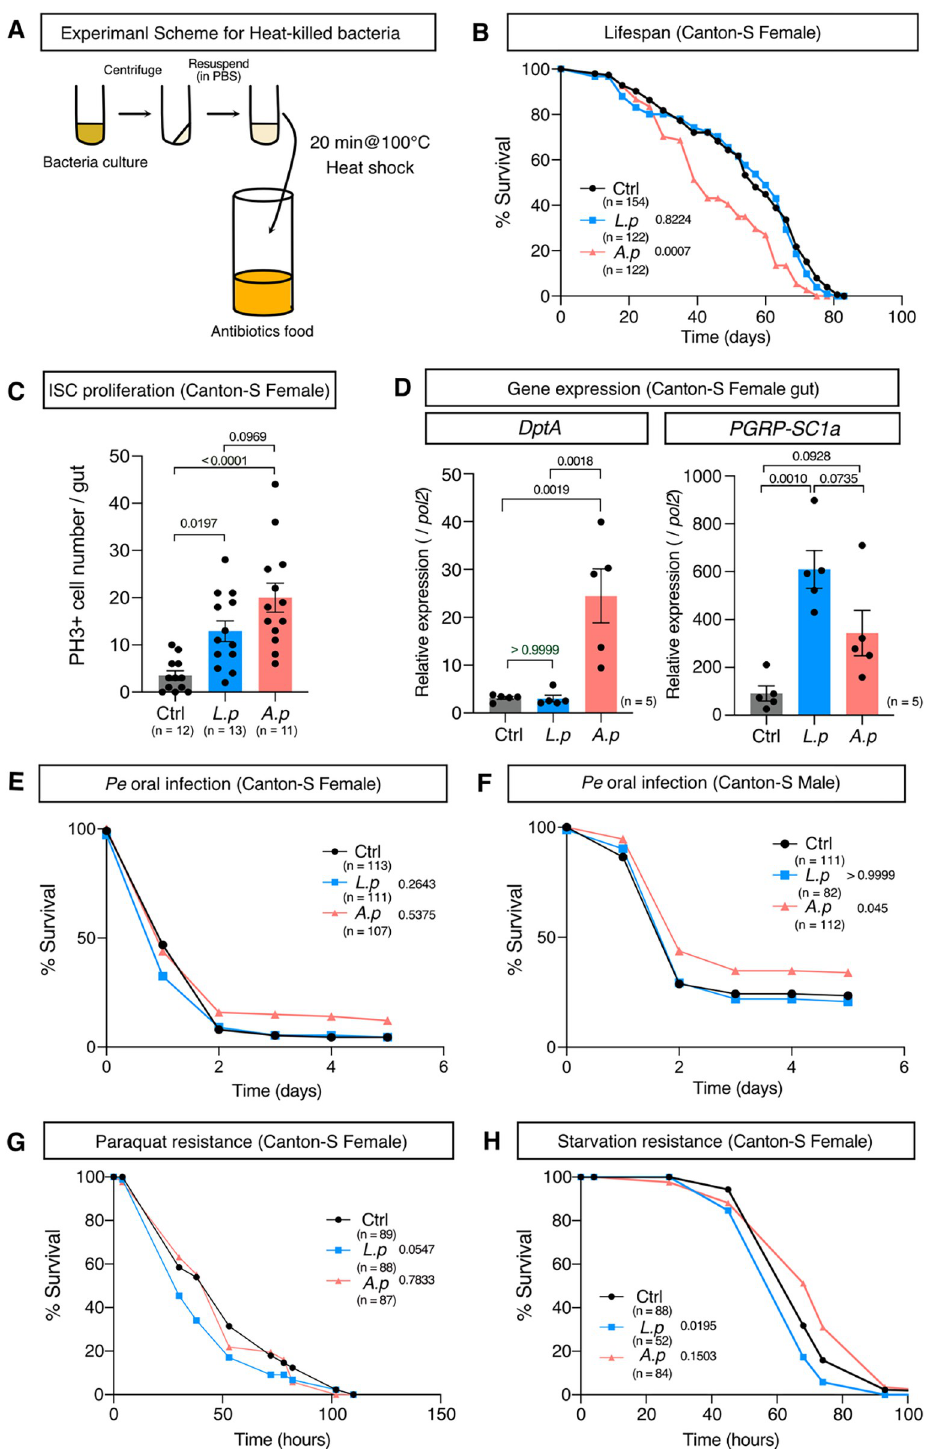
Fig 6. Heat-killed A . persici shortens lifespan and increases the host defence but does not enhance paraquat resistance. (A) An overview of the method to prepare the heat-killed bacteria (HK) diet. (B) Lifespan of female Canton-S flies fed the HK diet. A log-rank test was used to compare between control (Ctrl) and each HK diet. (C) Phospho-histone H3-positive cell numbers in the midgut of Canton-S female flies fed the HK diet for 40 days (Day45). For the statistics, ANOVA with Holm-Sˇı´da´k’s multiple comparison was used. (D) Quantitative RT–PCR of the